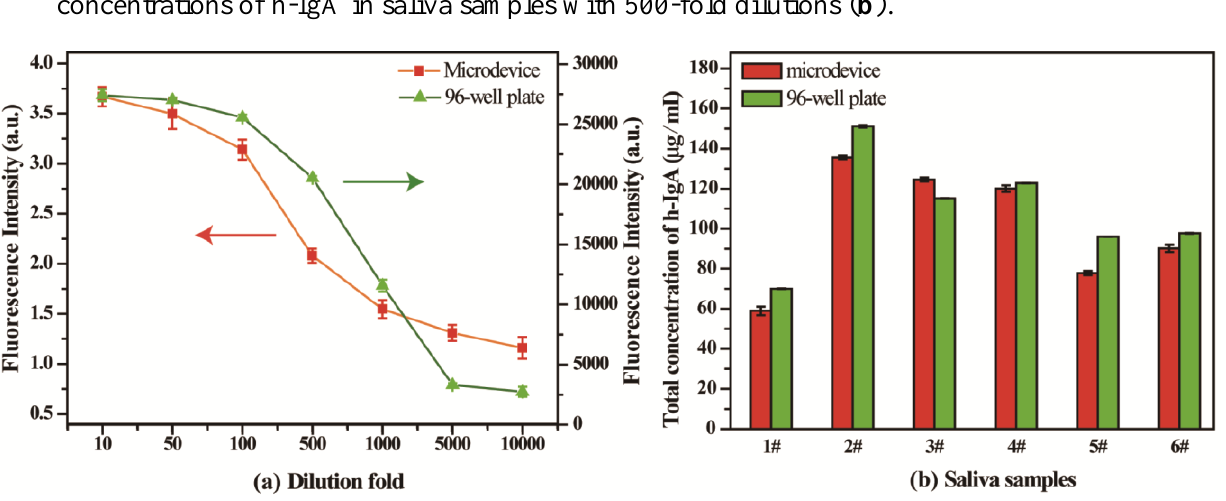
Figure 6. Measurements of saliva sediments by the present microwell and 96-well plate method: Investigations of the dilution factor on the measurement of h-IgA ( a ); Detection concentrations of h-IgA in saliva samples with 500-fold dilutions ( b